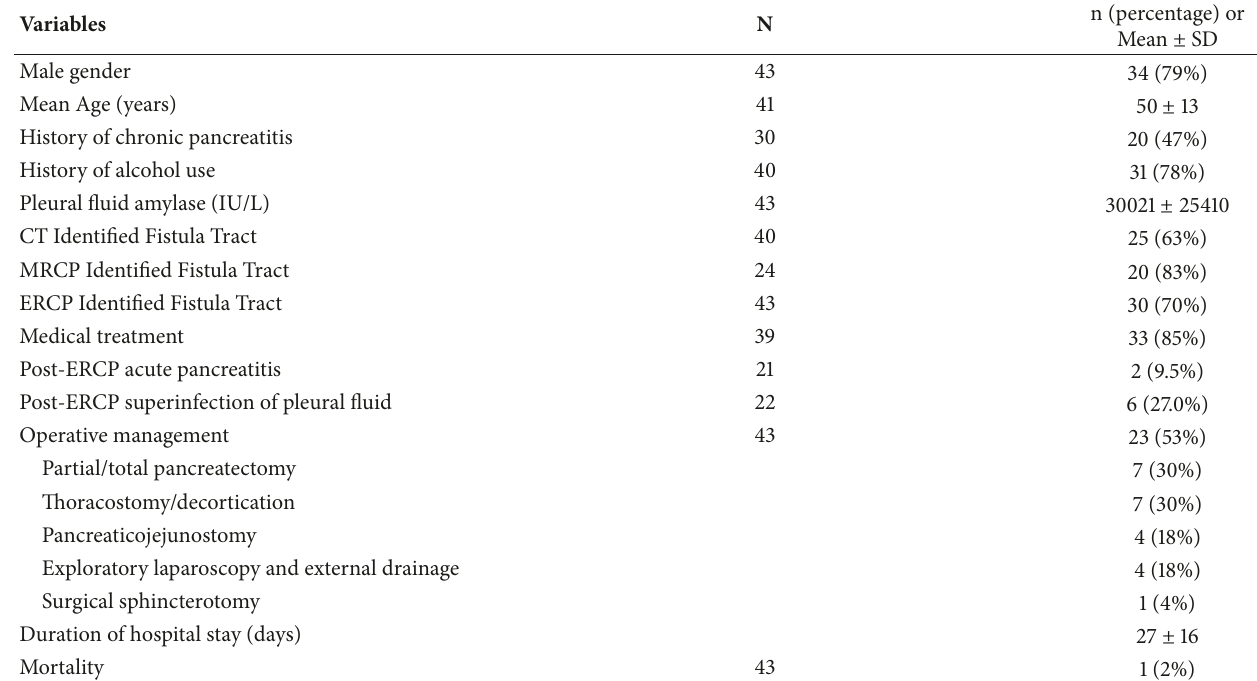
Table 1: Demographics and clinical data of previously reported cases of pancreaticopleural fistula between 2007 and 2017. N = total number of cases. n is the number of cases data reported. SD = standard